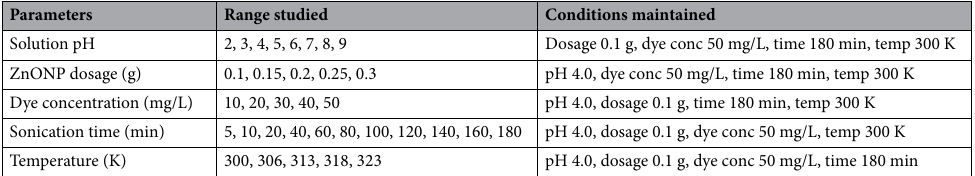
Table 1. Effect of various parameters and operating conditions on the adsorption of bromophenol blue onto